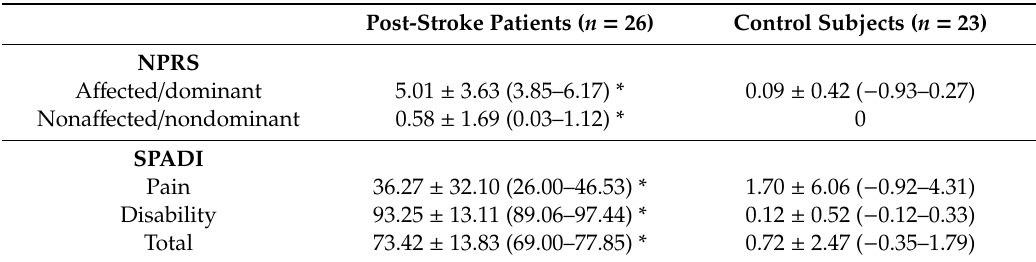
Table 1. Pain and disability perception in post-stroke patients and healthy